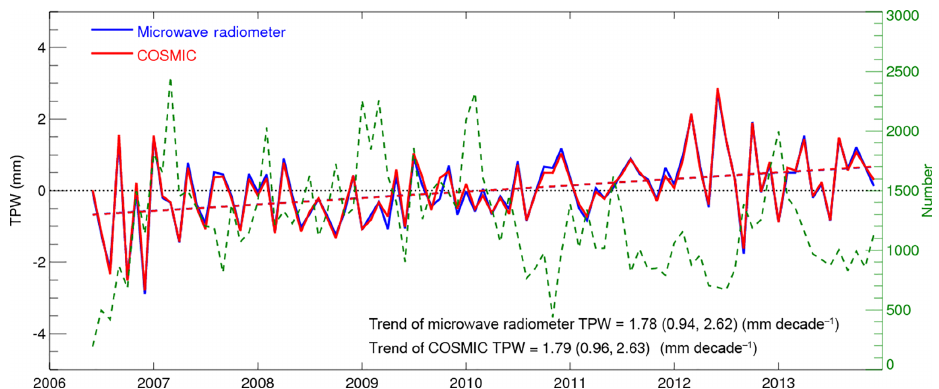
Figure 9. The deseasonalized time series of monthly mean TPW for all MW and COSMIC observations under all sky conditions. The red and blue dashed lines are the best fit of deseasonalized COSMIC and MW TPW time series, respectively.